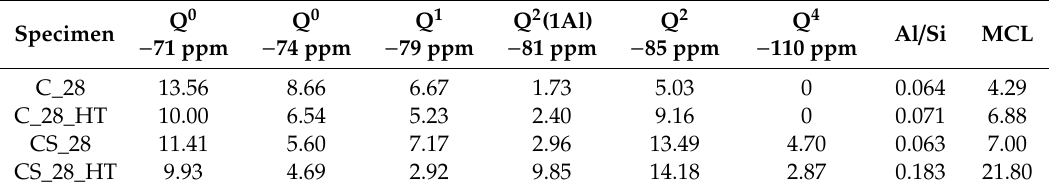
Table 3. Deconvolution results for 29 Si MAS NMR spectra, wt.%